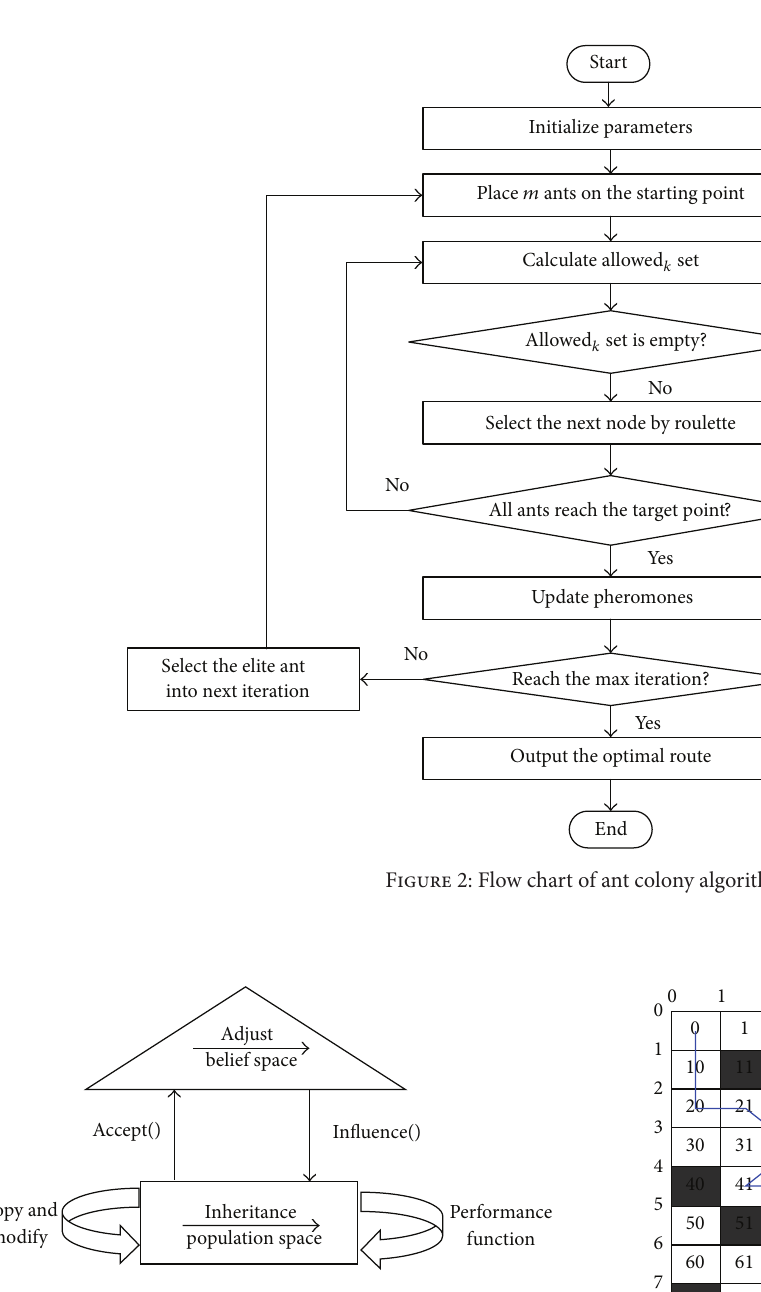
Figure 3: Basic framework of cultural algorithm.